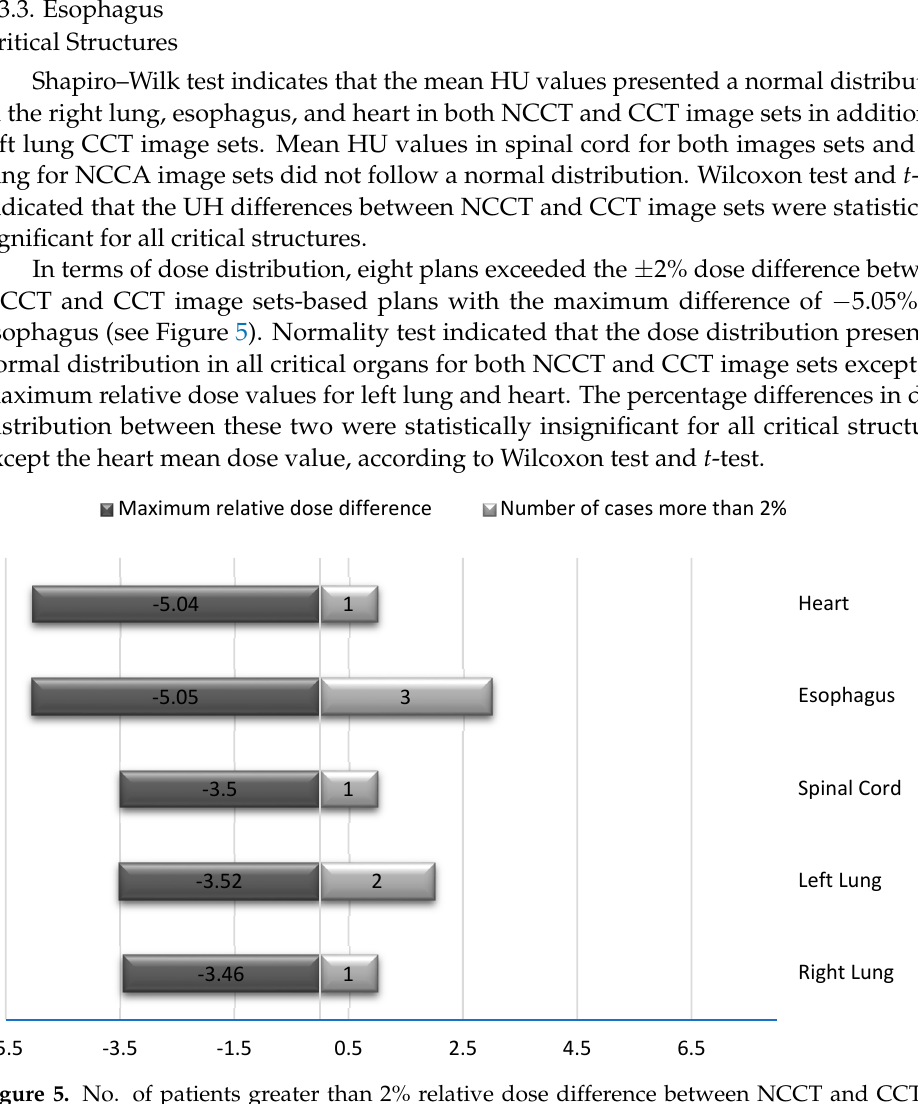
Figure 5. No. of patients greater than 2% relative dose difference between NCCT and CCT for esophagus critical structures.